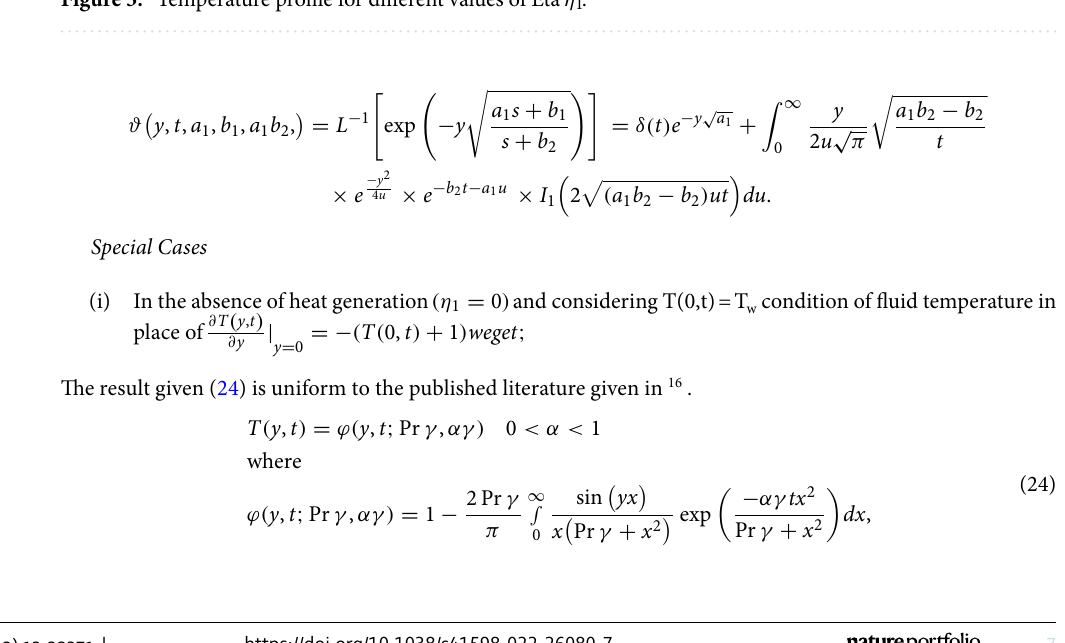
Figure 3. Temperature profile for different values of Eta η 1